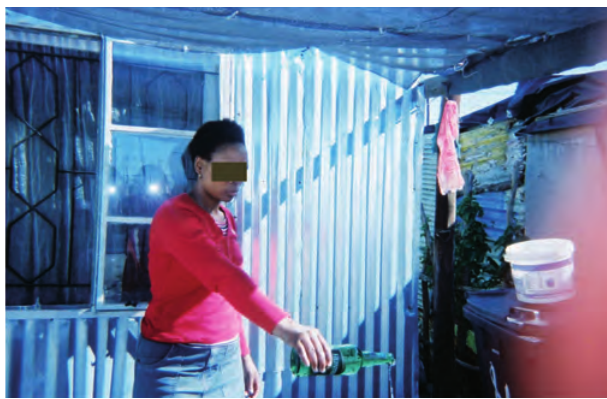
Fig. 3. A patient who struggled with an alcohol abuse problem depicts herself pouring out the remaining alcohol in her